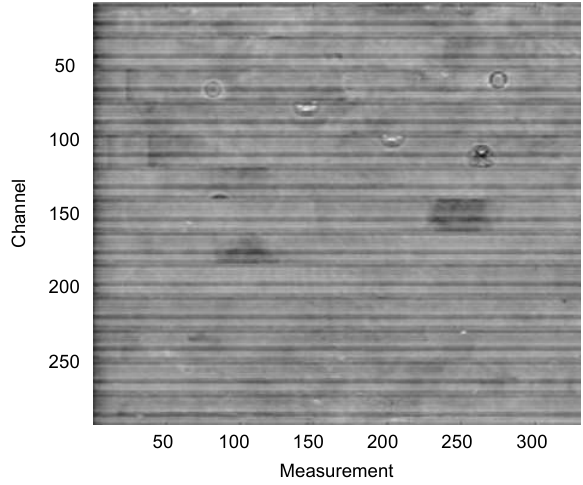
Figure 3 . Geometric shifts between the different tracks. Figure 4 . Result after applying shift